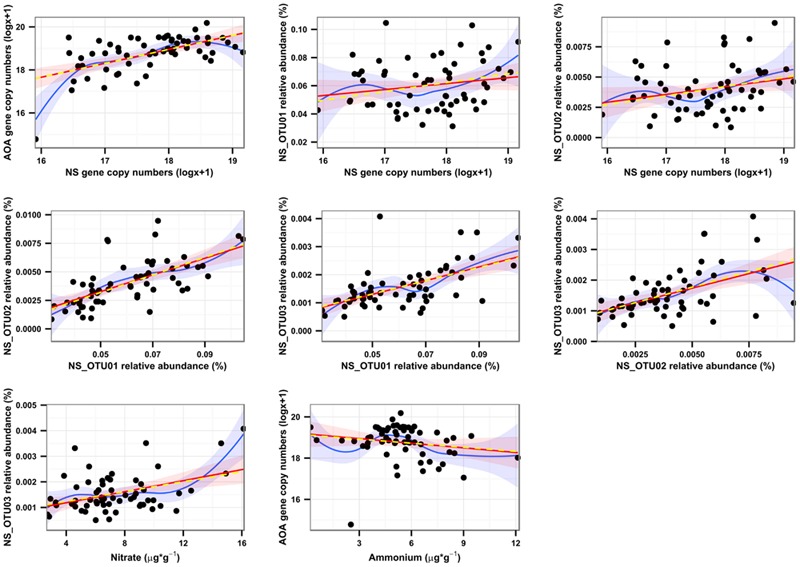
Univariate linear models between pairs of variables in October. Pairs of variables were selected from the network analysis (Figure 4) to show additional support for our conclusions after accounting for spatial autocorrelation. Red lines indicate the uncorrected, Gaussian regression models, whereas yellow, dashed lines represent the same models after correction for spatial autocorrelation. Blue lines are derived from Loess fits. All models are significant at p < 0.05, except for AOA/Ammonium (p > 0.1) and NS_OTU02/NS (p = 0.0565), which, however, show significant spearman rank correlations, possibly pointing at significant, non-parametric models. Although the model improvements for all variables were very small according to AIC shifts, NS and the NS OTUs 01 and 02 were best described with exponential variograms and NS OTU03 with the spherical variogram. For nitrate and AOA, no spatial model led to model improvements.